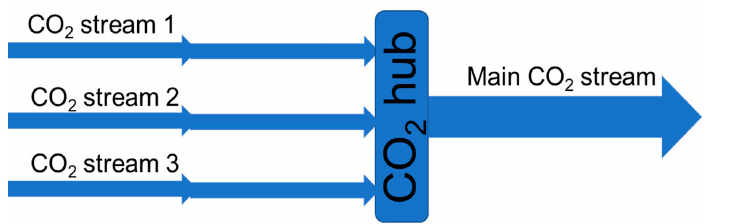
Figure 8. Illustration of several CO 2 streams mixed in a hub for then to follow one main flow to storage or utilization. storage or